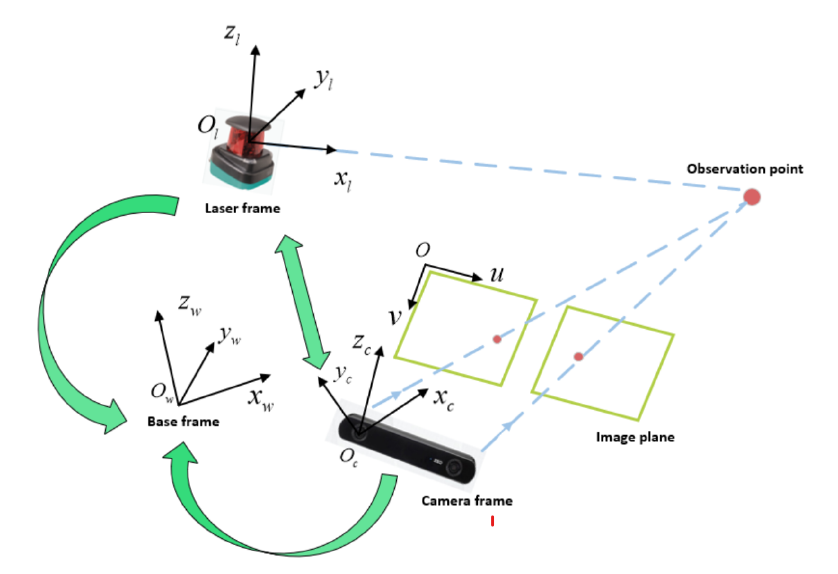
Figure 1. Relationship of coordinate